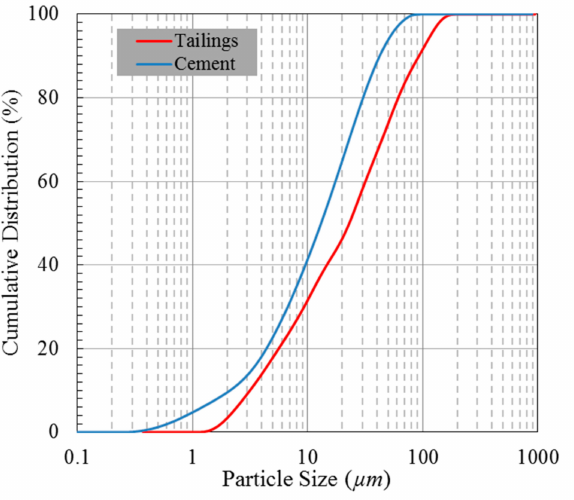
Figure 1. Particle size distribution of tailings and